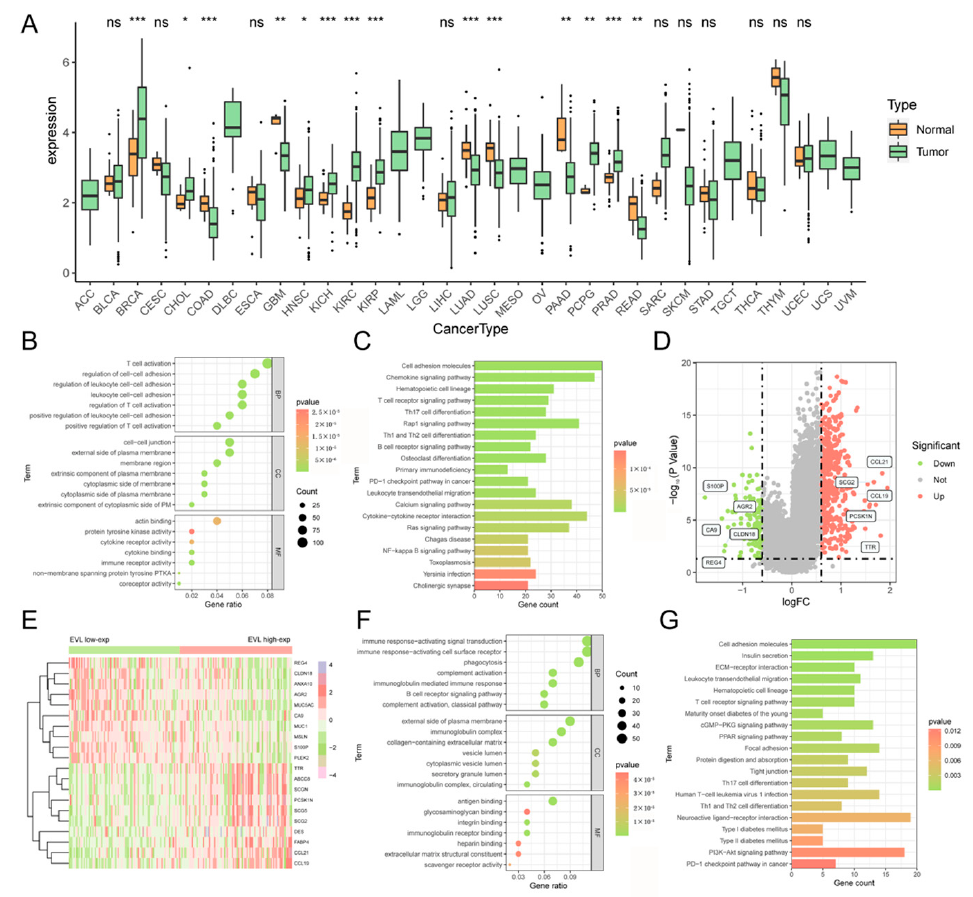
Figure 2. Comprehensive enrichment analysis associated with EVL. ( A ) EVL pan-cancer analysis in 33 types of tumors. ( B , C ) GO and KEGG analysis based on EVL co-expressed genes. ( D ) DEGs between EVL-high and EVL-low groups. ( E ) The heatmap of the top 20 DEGs. ( F , G ) GO and KEGG analysis based on EVL-related DEGs. EVL, Ena-VASP-like; GO, gene ontology; KEGG, Kyoto encyclopedia of genes and genomes; DEGs, differentially expressed genes. * p < 0.05, ** p < 0.01, *** p < 0.001, ns, not